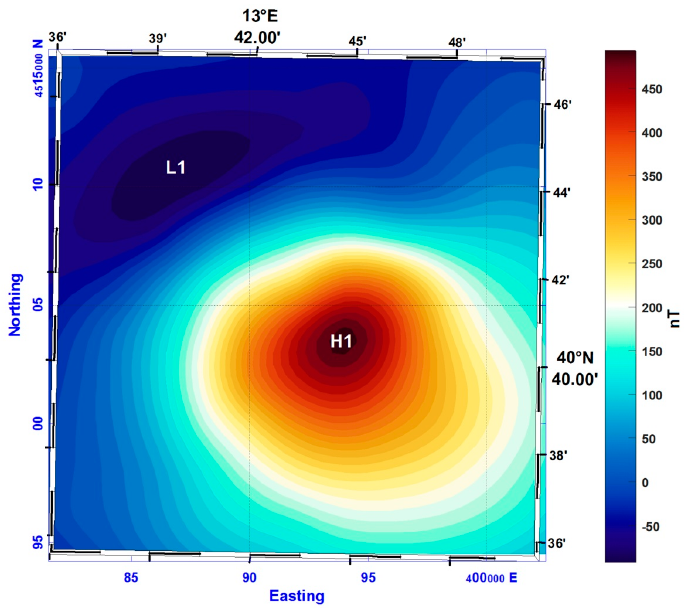
Figure 5. Total field aeromagnetic anomalies in the area west of Ischia Island at an elevation of 1463 m above sea level. Letters identify highs and lows of magnetic anomalies described in the text.